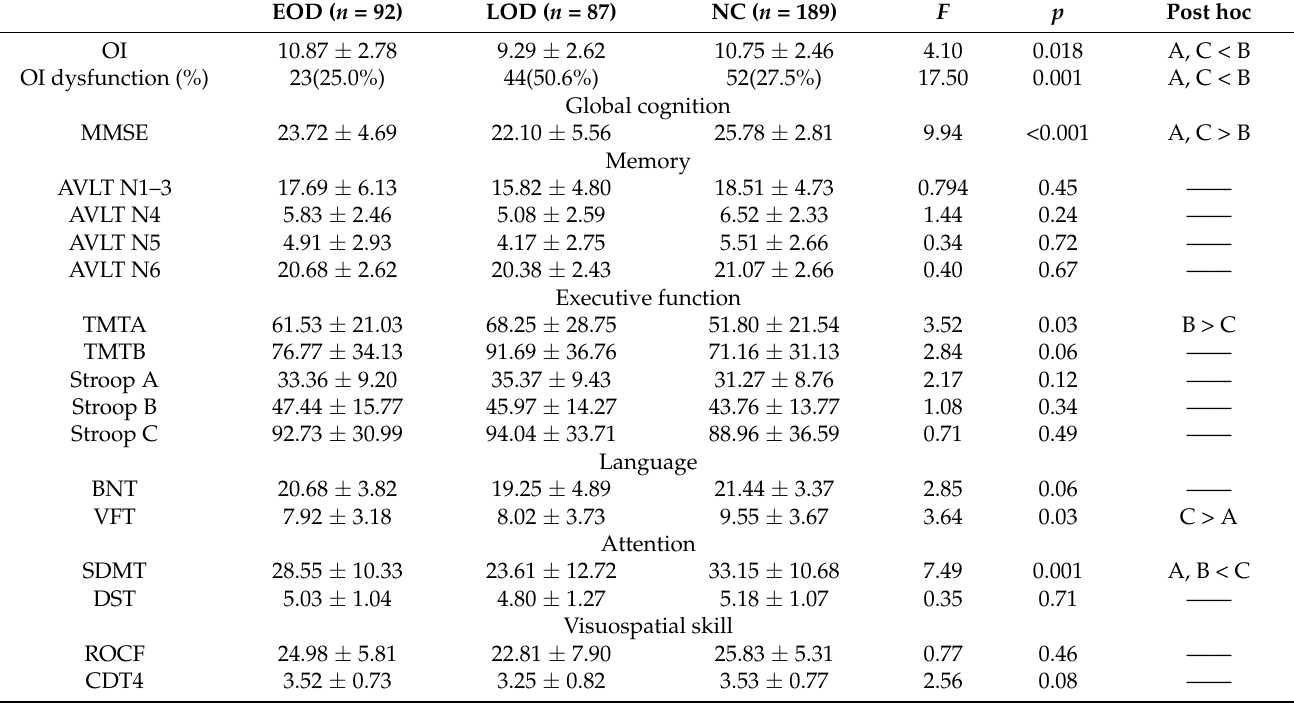
Figure 1. Comparison of the OI scores ( A ) and the percentage of OI dysfunction ( B ) among the EOD, LOD and NC groups. OI, odor identification; OI (%), percentage of OI dysfunction. EOD means patients with early onset depression; LOD means patients with late onset depression; NC means normal controls. * p < 0.05; ** p < 0.01. Table 2. Comparison of olfactory and cognitive functions between EOD, LOD and NC. EOD ( n = 92) LOD ( n = 87) NC ( n = 189) F p Post